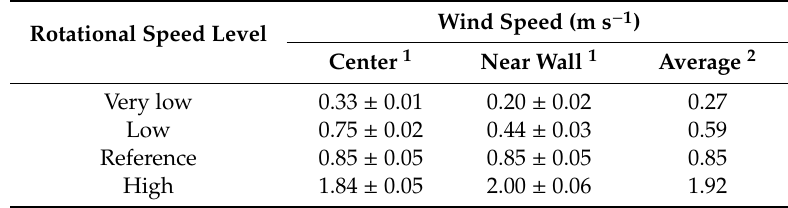
Table 1. Wind speed in the thoron calibration chamber at four rotational speed levels of direct current (DC)